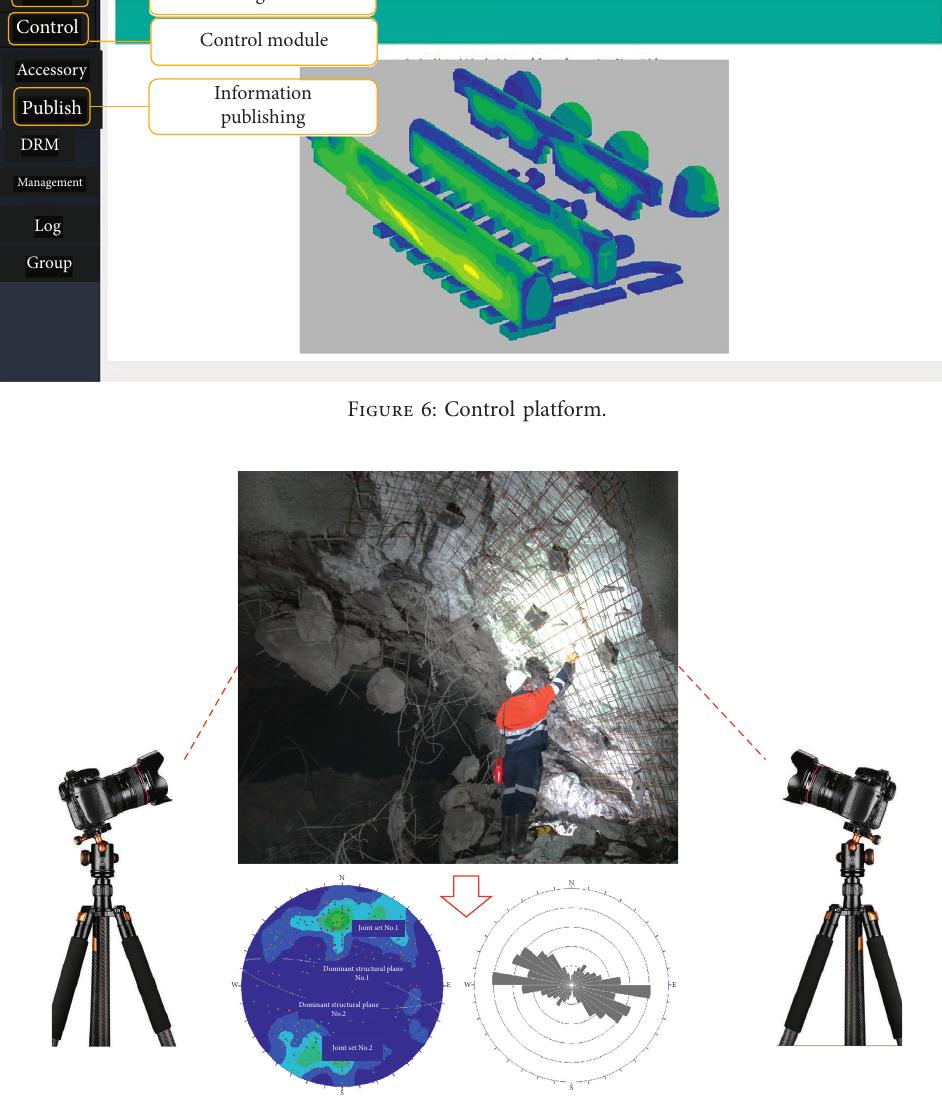
Figure 7: Site reconnaissance of engineering geology.